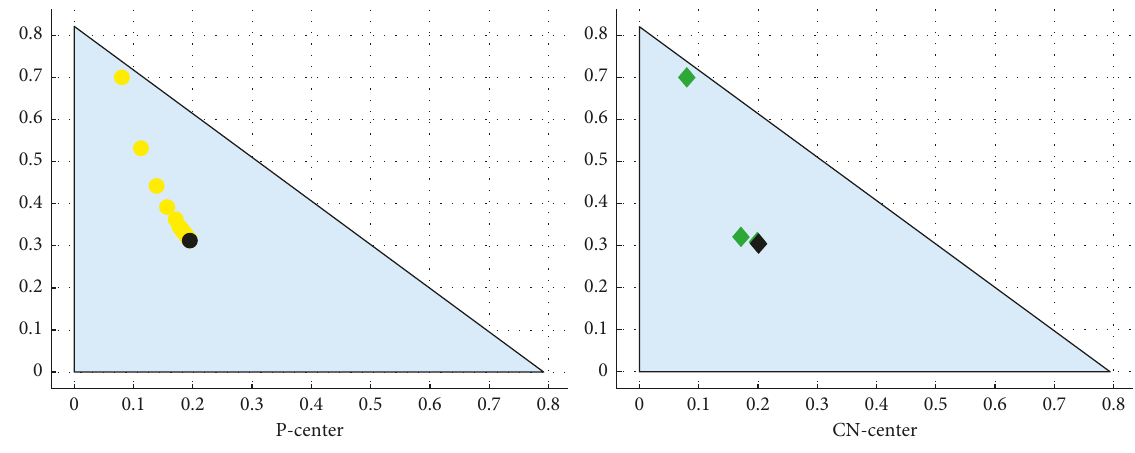
Figure 4: Polytope 4, convergence towards center. Table 1: A comparison of number of iterations and quality of P-center and CN-center.